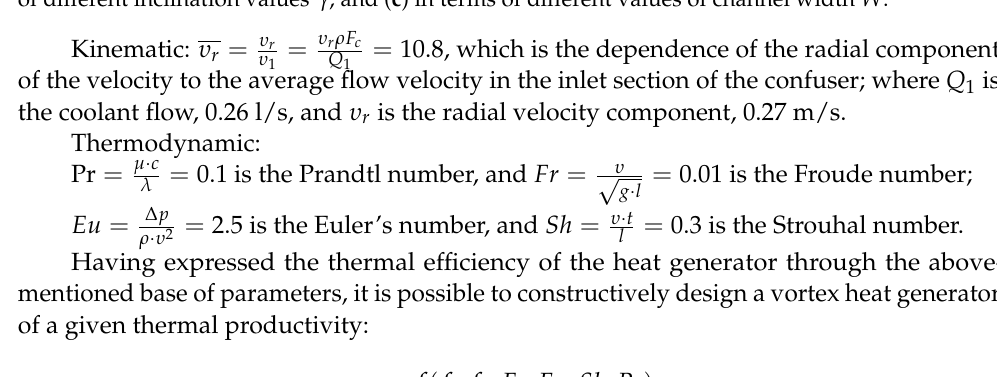
Figure 10. Changes of V r velocity: ( a ) in terms of different values of pipe Q i performance, ( b ) in terms of different inclination values γ , and ( c ) in terms of different values of channel width W .